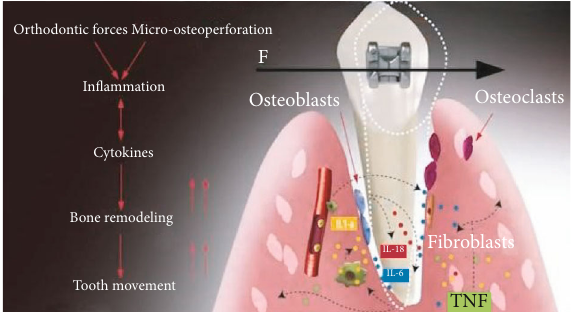
Figure 3: Mechanotransduction of the bone by the action of orthodontic forces. When the orthodontic forces produce the movement of the dental organ, on the side towards which these forces are directed, they cause the osteoclasts to activate, producing osteolysis of the bone. In the same way, on the opposite side, the osteoblasts are activated, producing bone